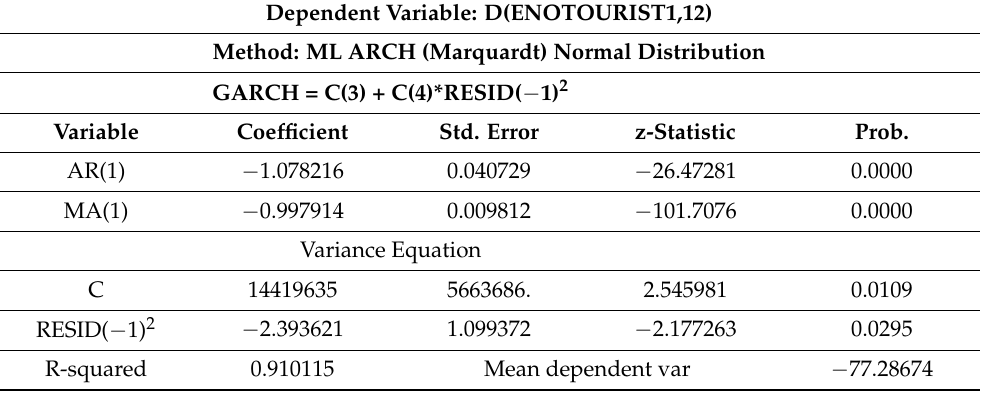
Table 5. Estimation results for the GARCH model.